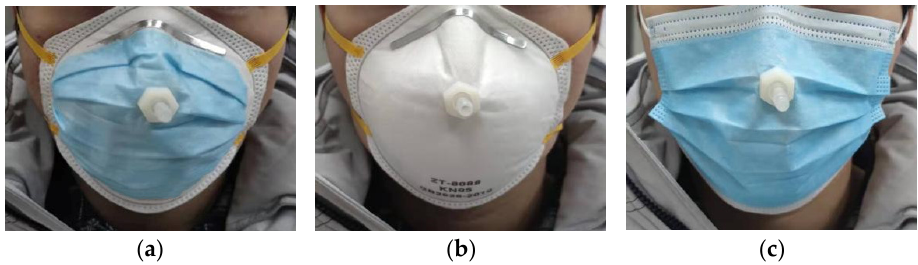
Figure 2. Three face masks for measurement tests: ( a ) modified face mask, ( b ) N95 face mask ( c ) surgical face mask.